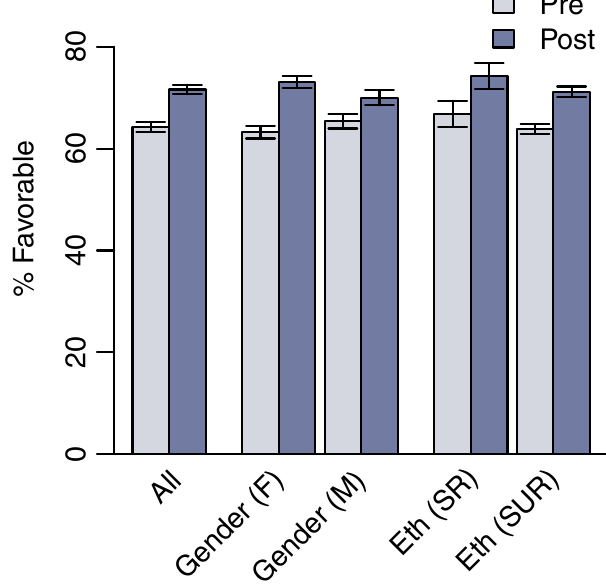
FIG. 1. Overall favorable average CLASS scores for Modeling Instruction sections. Bars show standard error of the mean.